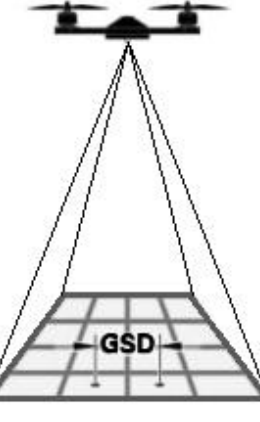
Figure 4. Ground sampling distance